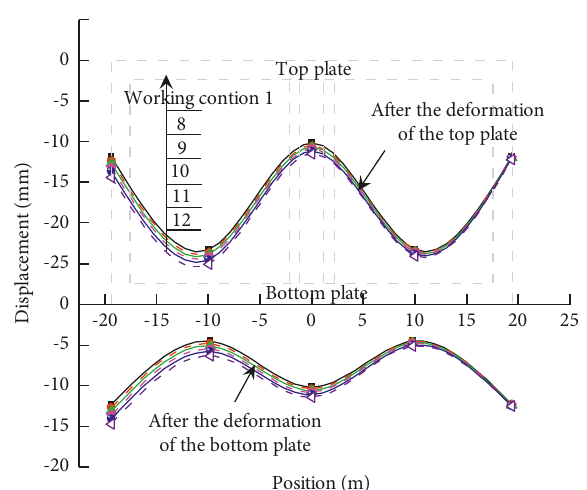
Figure 21: The dislocation magnitude under different torsion